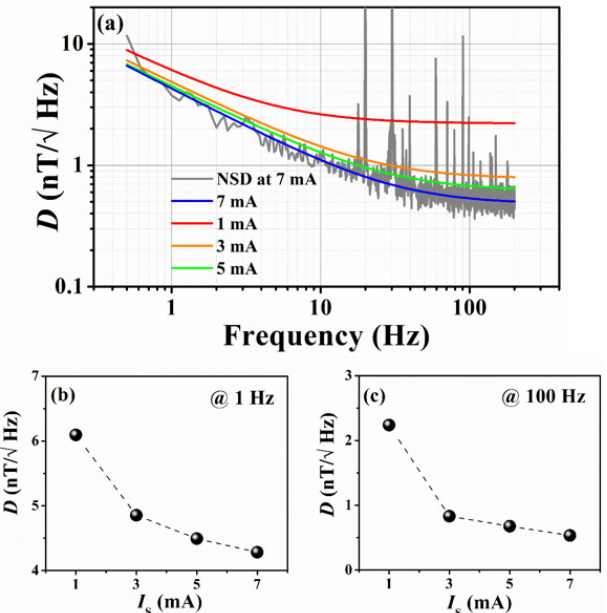
Figure 11. ( a ) Detectivity for tri-mPHMR sensor for different currents in CC mode; recorded room temperature NSD at 7 mA is shown in the background (gray); ( b and c ) exhibit change in detectivity at 1 Hz and 100 Hz, respectively (with dashed lines as a guide to the eye). Table 4. Detectivity for PHMR sensors for different sensing currents in CC mode.